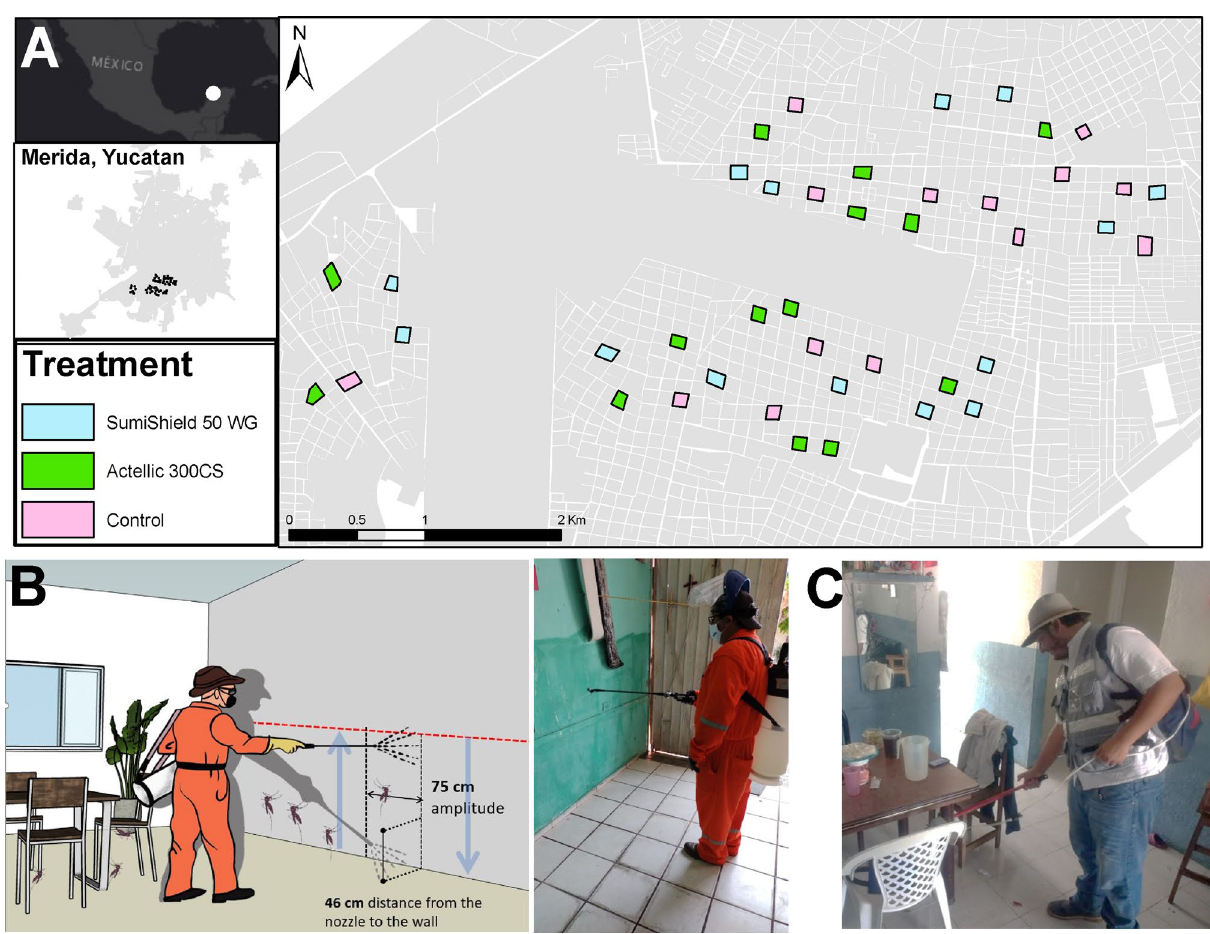
Figure 1. Overall trial design. ( A ) Distribution of clusters randomly selected for the CRCT and study arms (colors) in the city of Merida, Yucatan, Mexico (map inset). Images show the implementation of TIRS during the study ( B ) and an entomologist using Prokopack aspirators ( C